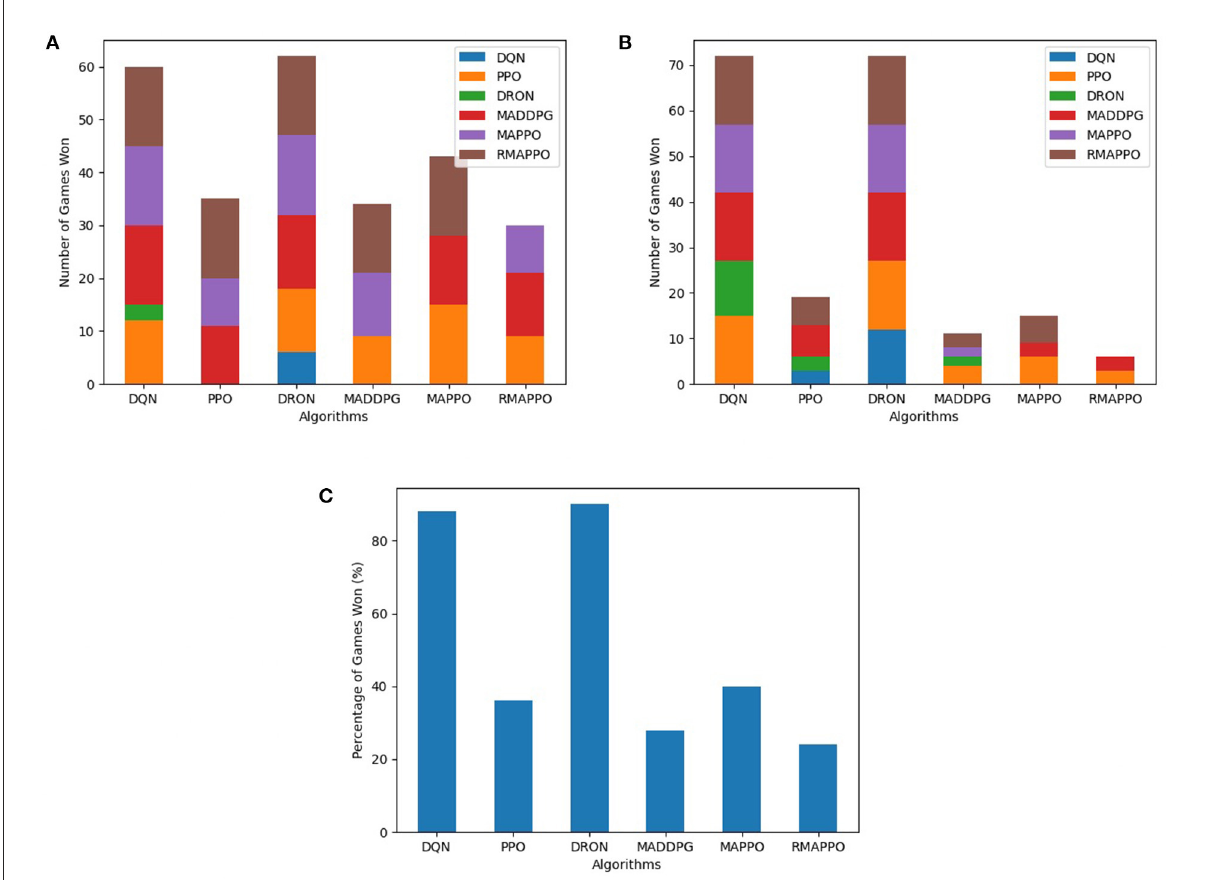
FIGURE4 Performance of various algorithms when playing against other algorithms in Pong. (A) Shows the number of games won as the first player, (B) shows the number of games won as the second player, (C) shows the overall win rate